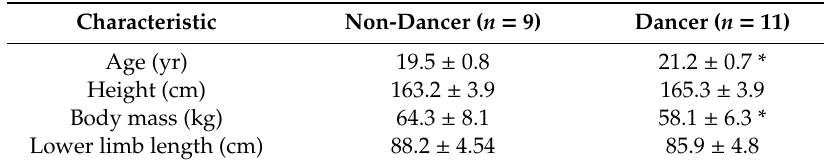
Table 1. Descriptive characteristics of participants. * indicated significantly di ff erent from non-dancer ( p < 0.05). Data are presented as mean ±